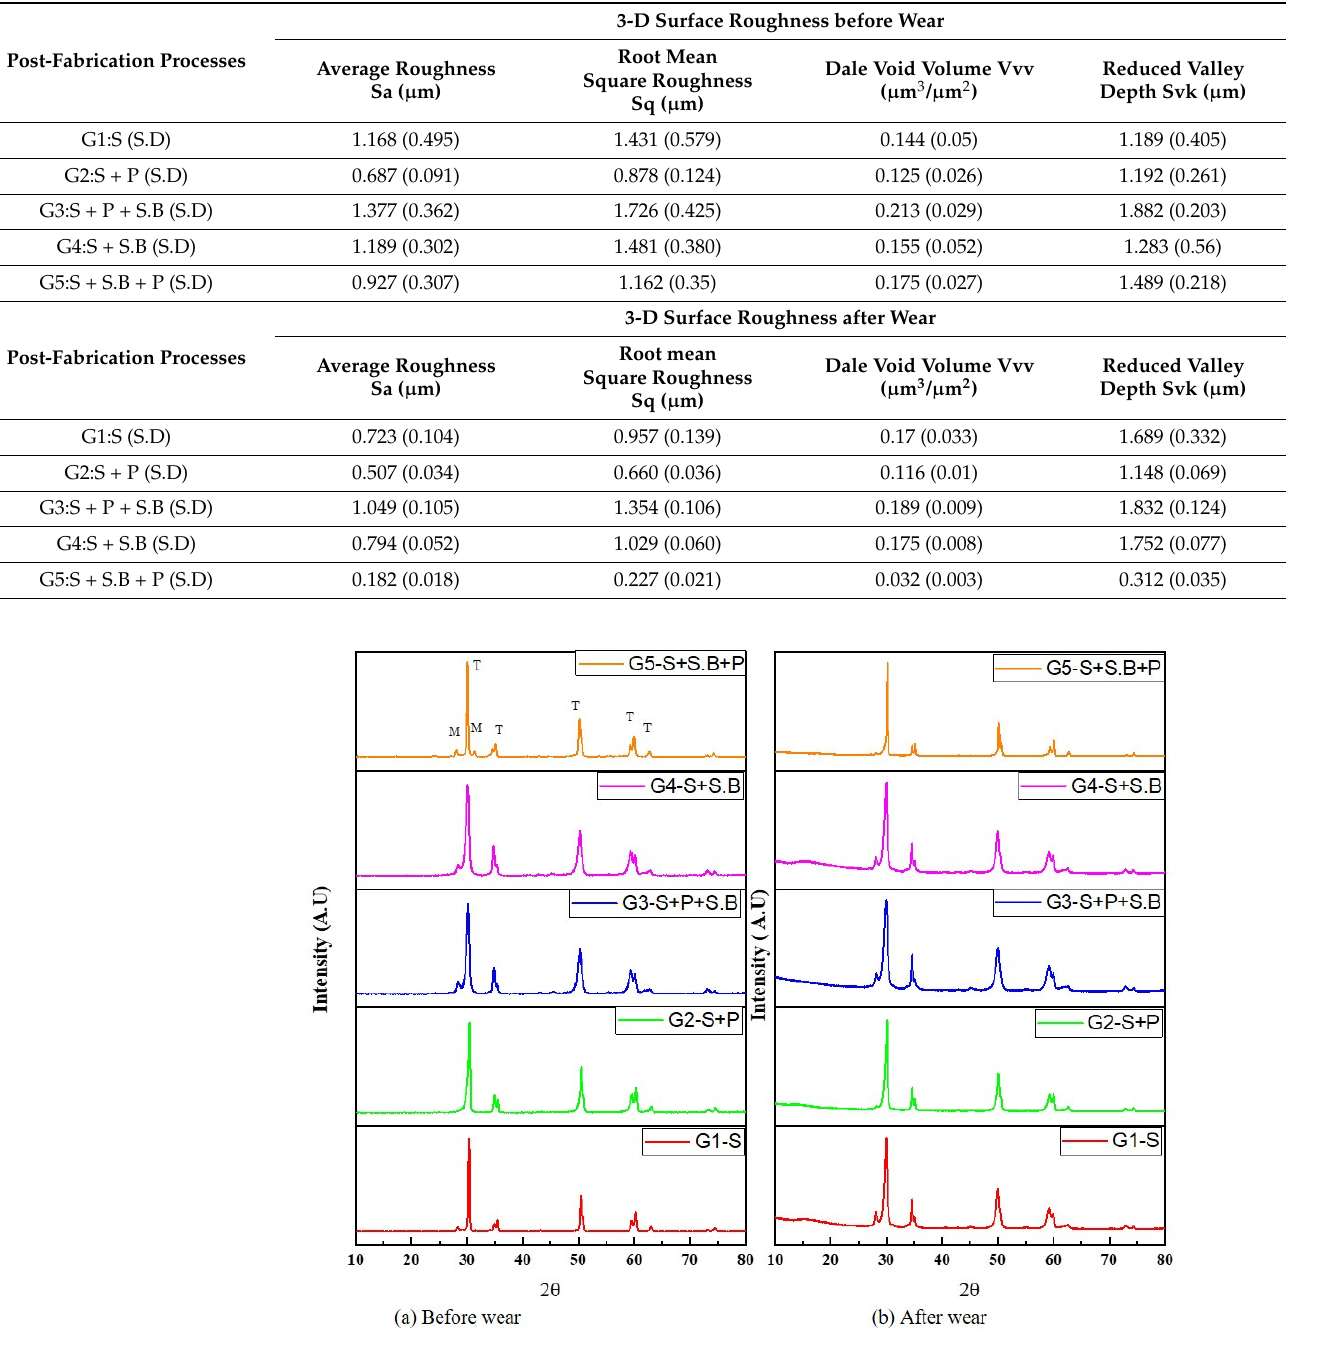
Table 1. Surface roughness values of the specimens subjected to different surface treatments before wear and after wear.